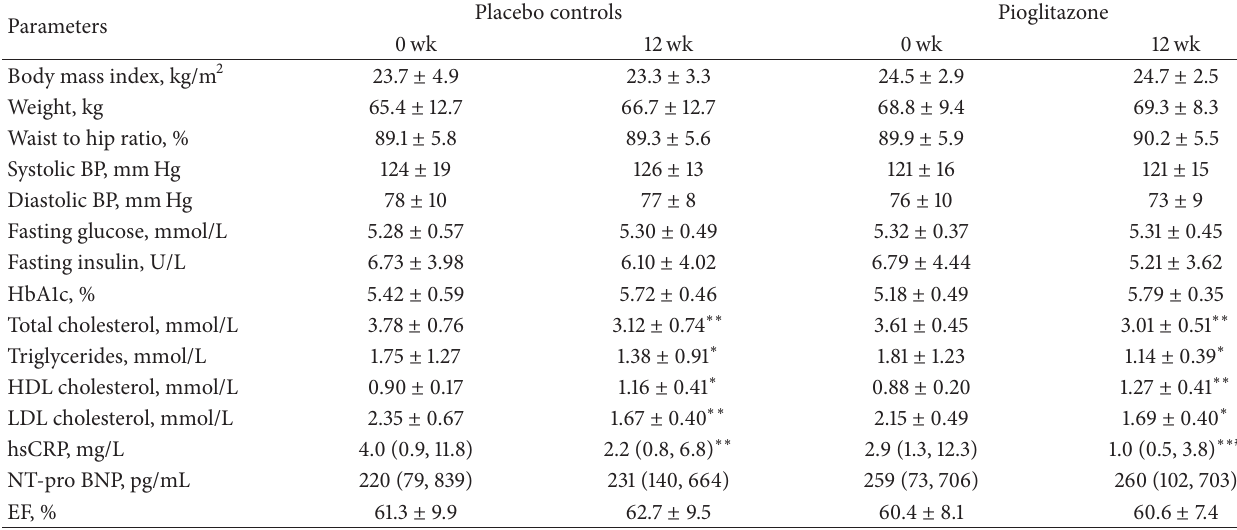
Table 2: Metabolic and other parameters at baseline and after 12